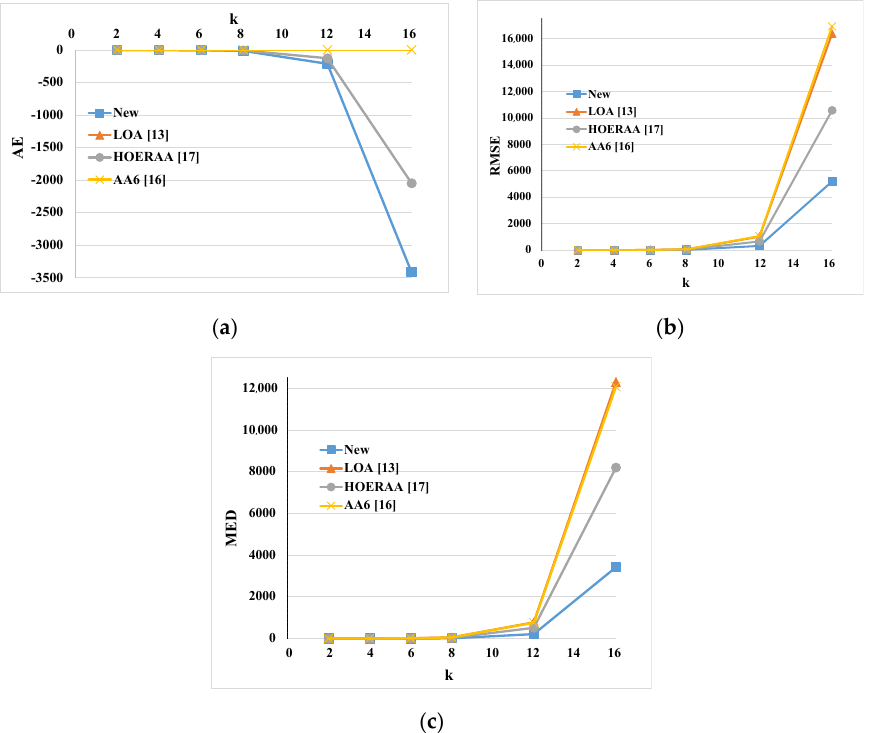
Figure 6. Error metrics versus k : ( a ) the Average Error (AE); ( b ) the Root Mean Square Error (RMSE); ( c ) the Mean Error Distance (MED).